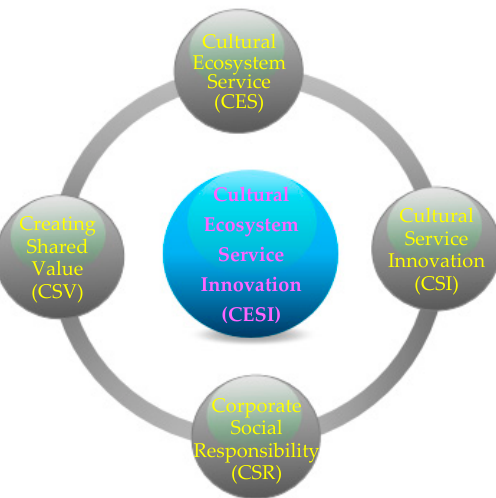
Figure 2. Cultural Ecosystem Service Innovation (CESI) factors.